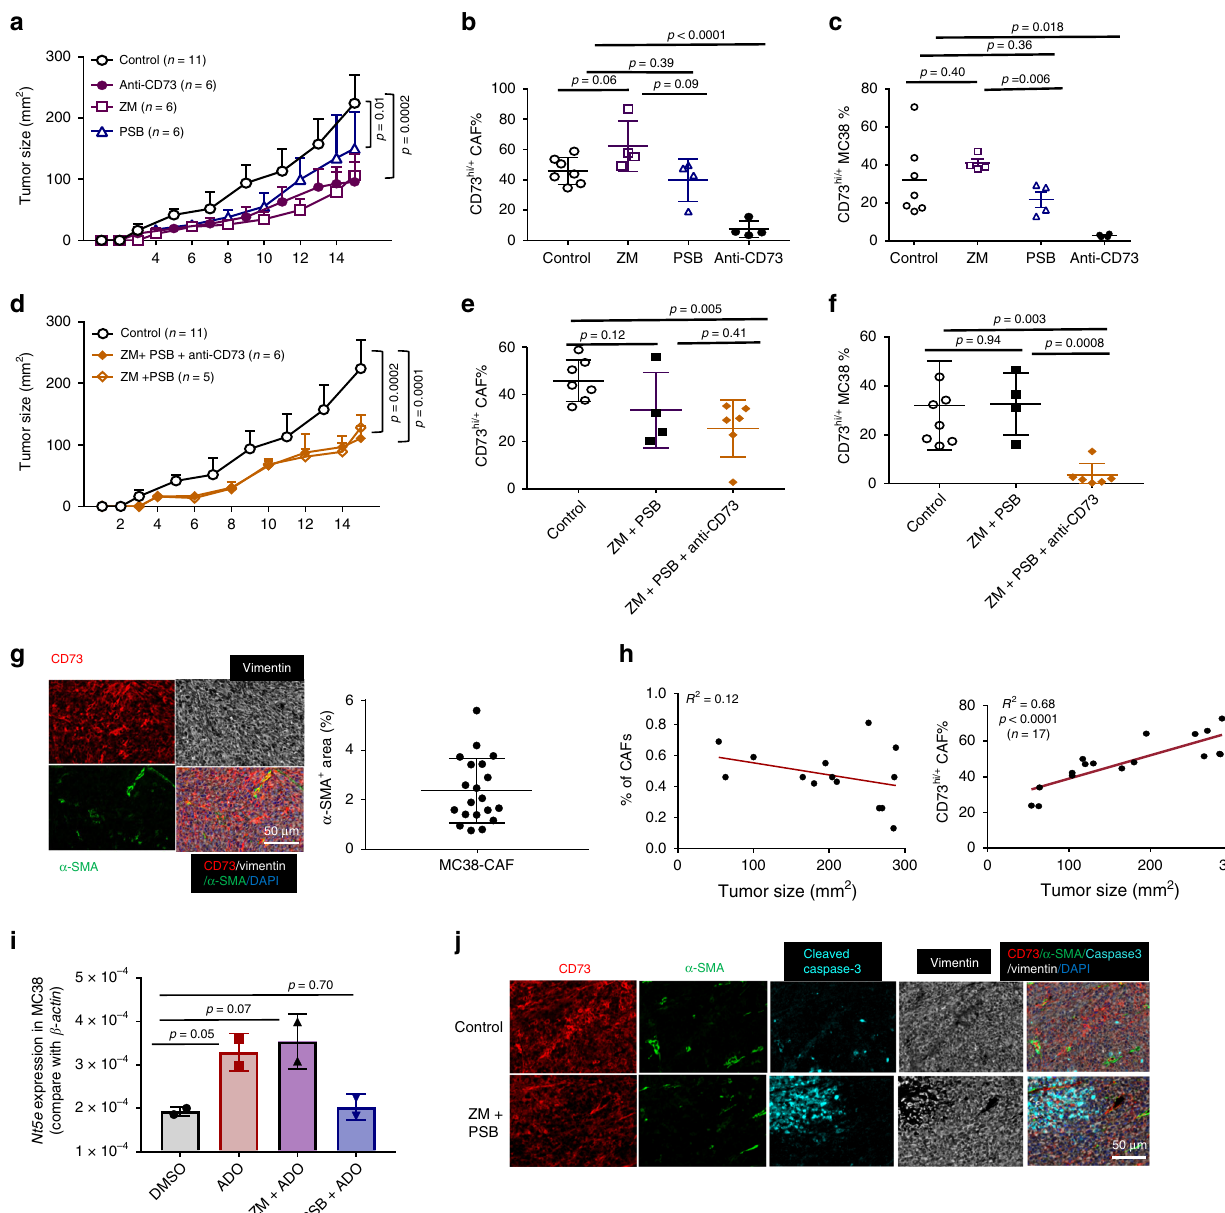
Fig. 7 Adenosinergic antagonism is ineffective in modulating CAF-CD73 expression in the CAF-poor MC38 tumors. a MC38 tumor-bearing mice were treated with daily i.p. injection of A 2A antagonist ZM241385 or A 2B antagonist PSB1115 or anti-CD73 every other day. Tumor progression was examined every day. b , c The percentage of CD73 hi/ + CAFs ( b ) and MC38 tumors ( c ) in the TME following different treatments were analyzed via FACS. d MC38 tumor progression in WT mice receiving combination treatment of ZM243185 and PSB1115 in the absence or presence of anti-CD73 was examined every day. e , f The percentage of CD73 hi/ + CAFs ( e ) and MC38 tumors ( f ) in the TME following different treatments were analyzed via FACS. g Representative images of IHC staining of CD73 (red), α -SMA (green), and vimentin (white) revealed their levels and distribution within the MC38 TME. The percentage of a-SMA + signal covering the entire TME was determined via the Inform software and presented to the left. h MC38 tumor established in WT mice were collected at different sizes for FACS analysis. The relative CAF abundancy and CD73 hi/ + CAFs within the MC38 TME in association with tumor size were evaluated via linear regression. i MC38 tumors were cultured with 100 μ M ADO in the absence of presence of 10 mM ZM241385 or PSB115 for 48 h. Their Cd73 mRNA levels relative to that of b-actin was analyzed via real-time RT-PCR. j Representative images of IHC staining of CD73 (red), α -SMA (green), apoptotic cells (cleaved caspase-3 + , cyan) and vimentin (white) levels and their distribution in the MC38 TME treated with or without ZM241385 and PSB115. a , d p values were determined via multiple t -tests where the tumor sizes at each time point were compared. b , c , e , f , g , i Error bars depict mean ± SEM. p values were determined via two-tailed unpaired Student ’ s t -test. g , h Scale bars, 50 μ m. All experiments were repeated at least two times. Source data are provided in the Source Data fi